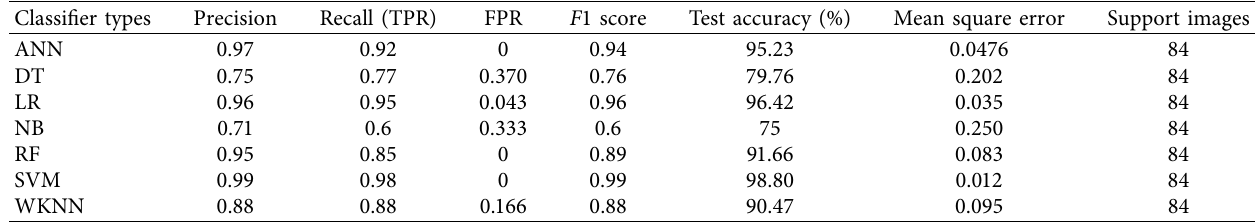
Table 9: Image testing in seven machine learning classifers.